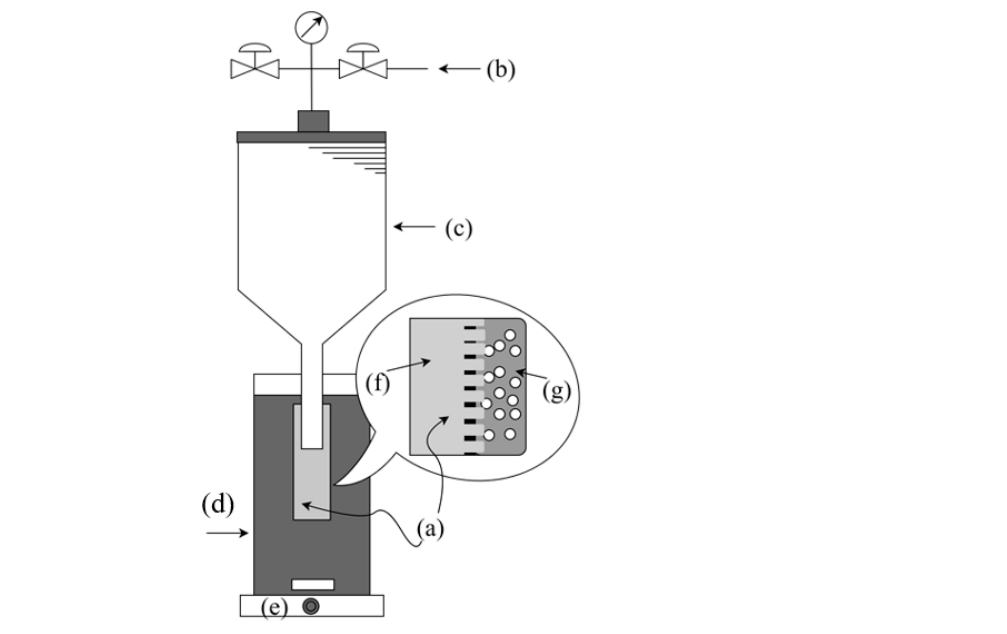
Figure 8. Schematic representation of the experimental system used for the preparation of O/W emulsion using porous glass membrane: ( a ) membrane; ( b ) compressed gas; ( c ) dispersed (oily) phase reservoir; ( d ) emulsion reservoir and continuous phase (aqueous phase); ( e ) and—magnetic stirrer; ( f ) dispersed phase; ( g ) continuous phase.